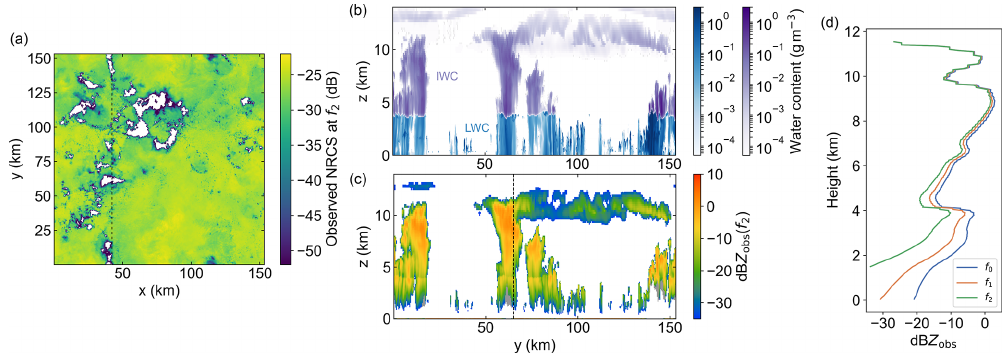
Figure 2. Selected results from GATE forward simulations. (a) Observed surface NRCS at f 2 = 174 . 8GHz. Surface echoes with SNR below the detection threshold appear as white and generally correlate with convectively active regions with large liquid and ice water content (LWC and IWC) values. (b) Two-dimensional cross section of model condensed water profiles (ice and liquid) for the along-track path (dashed line) in panel (a) . (c) Corresponding observed reflectivity profiles at 174.8GHz. Gray regions in lower-tropospheric convective cores indicate regions where the multiply scattered signal is at least 3dB higher than the single-scattering reflectivity. We assume that these grid points can be filtered out before performing water vapor retrievals. (d) Vertical reflectivity profiles at all three DAR frequencies corresponding to the dashed line in panel (c) .